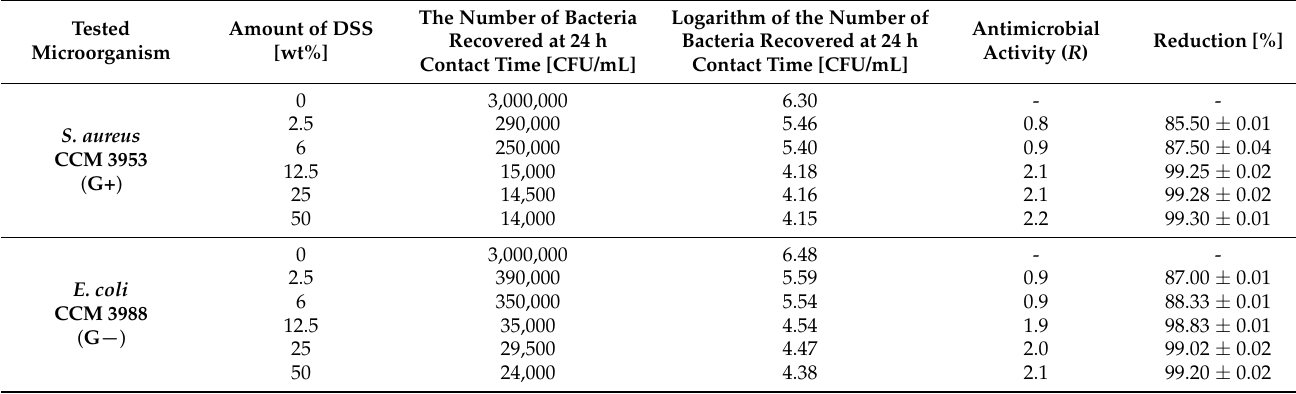
The results of antimicrobial activity and reductions are listed in Table 5. Table 5. Antibacterial activity and efficacy (quantitative) Staphylococcus aureus CCM 3953 and Escherichia coli CCM 3988. The concentration of bacteria in the test inoculum is 500,000 CFU/mL. The Number of Bacteria Logarithm of the Number of Tested Amount of DSS Antimicrobial Recovered at 24 h Bacteria Recovered at 24 h Microorganism [wt%] Activity ( R ) Contact Time [CFU/mL] Contact Time [CFU/mL]